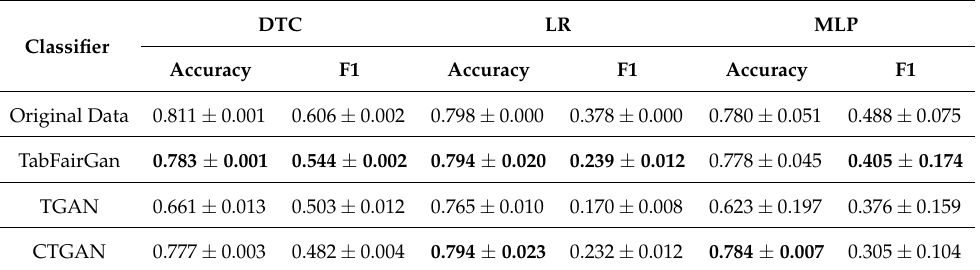
Table 1. Comparing the results TabFairGAN for accurate data generation with TGAN and CT- GAN